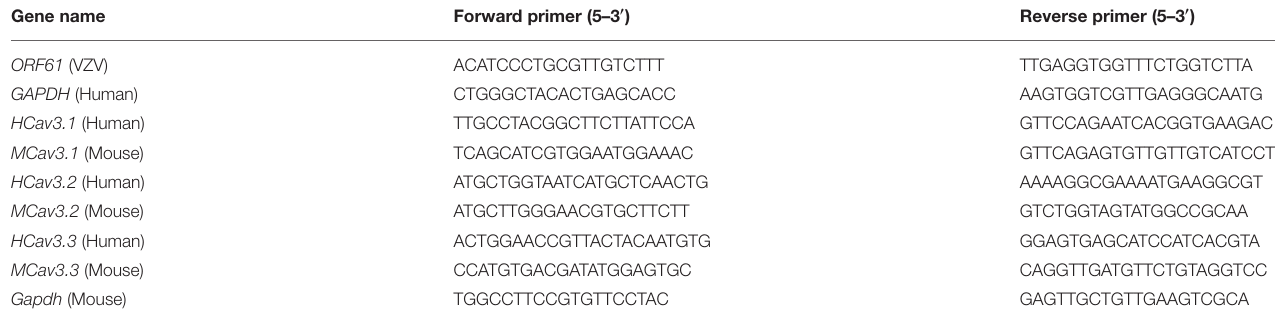
TABLE 1 | Sequences of the primer for quantitative real-time PCR